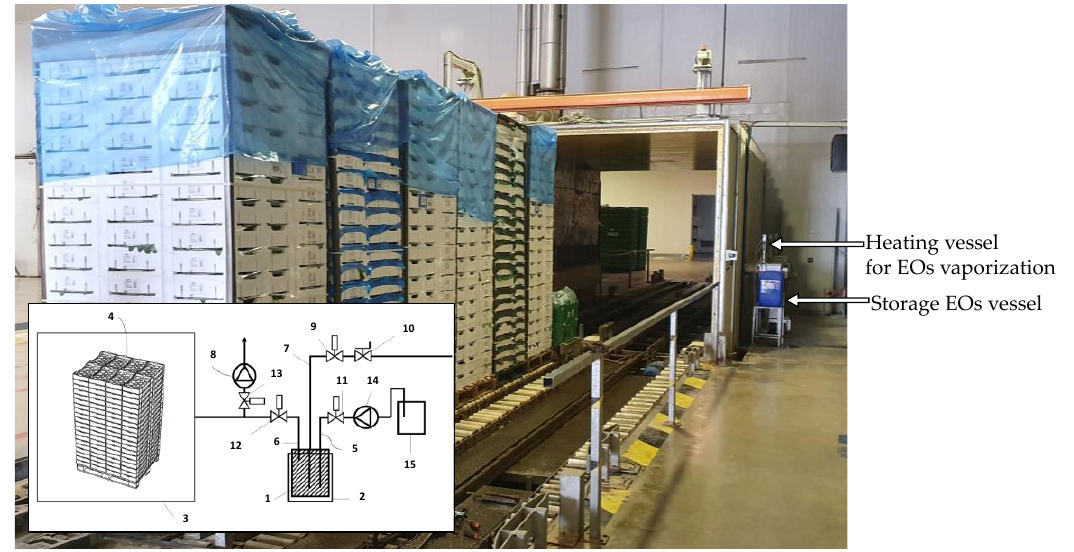
Figure 3. Industrial vacuum cooling system coupled to an essential oil (EO) vaporization installation, based on the SDuVC technology. In the schema of the bottom left-corner: (1) is the EOs evaporator heated by (2) a jacket; (3) is the vacuum camera where EO vapors are applied (at the end of the vacuum cooling process) on (4) the fresh produce packaged in open cases; (5), (6) and (7) are connection tubes and (8) is a vacuum pump; (9), (10), (11), (12) and (13) are valves; and liquid EOs are dosed with (14) a dosing pump, taking the EOs from (15) a jerrycan.